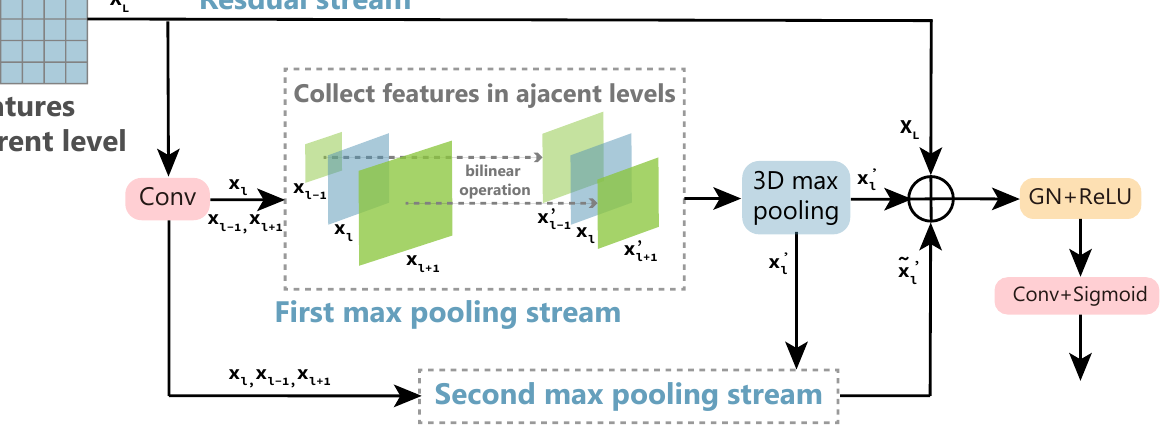
Figure 3. The diagram of proposed Disentangled Max Pooling Filter (DeMF). ‘GN’ indicates the group normalization [39]